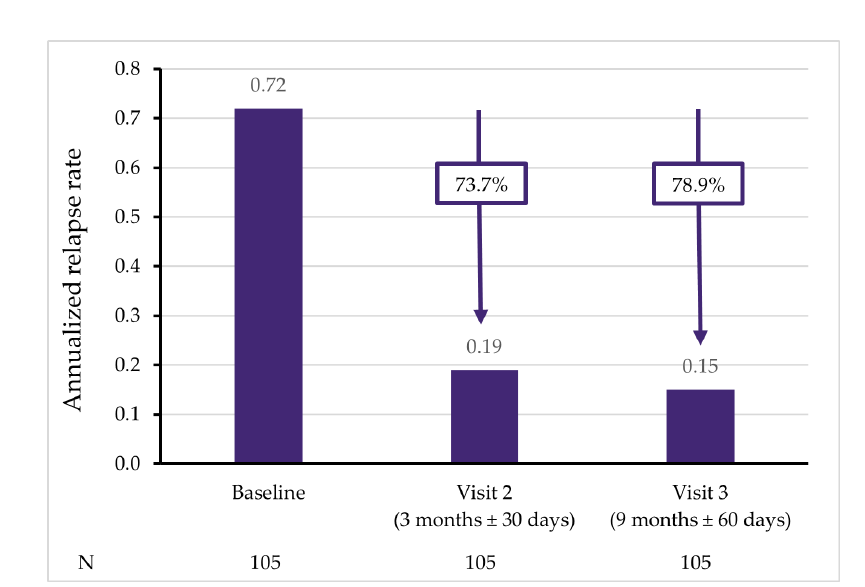
Figure 2. The annualized relapse rate after 3 and 9 months of teriflunomide